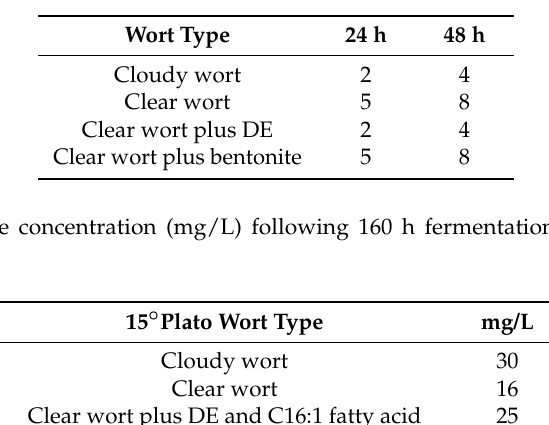
Table 6. Concentration of CO 2 (g/L) present during fermentation of 15 ◦ Plato worts [32].